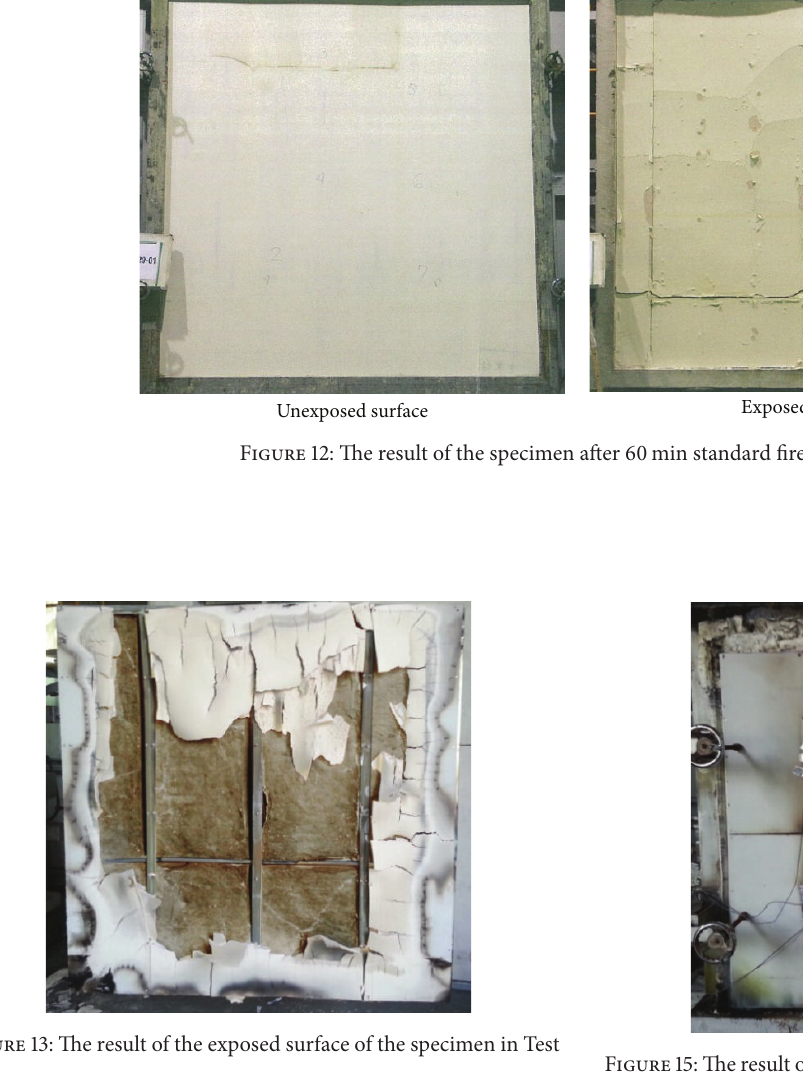
Figure 15: The result of the unexposed surface of the specimen after 43.8 min standard fire test in Test